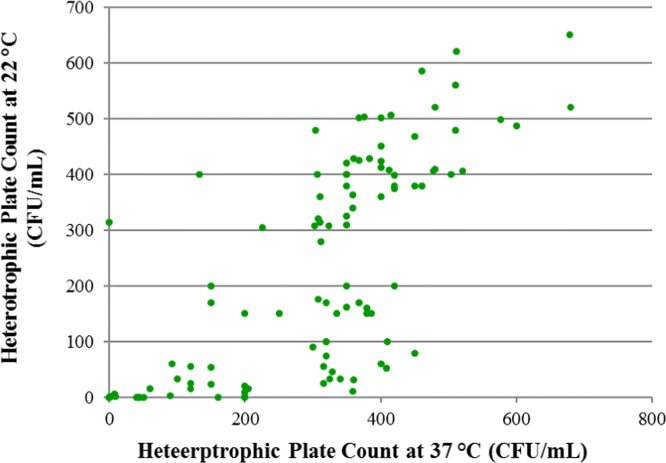
Scatter Plot showing the observed relationship between the Heterotrophic Plate Count at 37 °C and at 22 °C (CFU/mL). Pearsons’ r = 0.7293; r2 = 0.5319. Cold (< 30 °C) water samples included. 33 samples not included in the construction of the plot because the one of the HPCs was over 800 CFU/mL, so that it couldn’t be determined with accuracy.